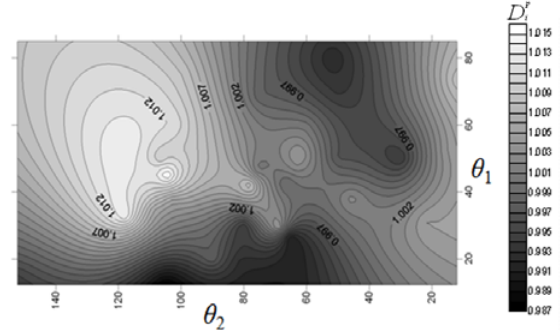
p , θ and D ,i at Re = 20. 1 2 D